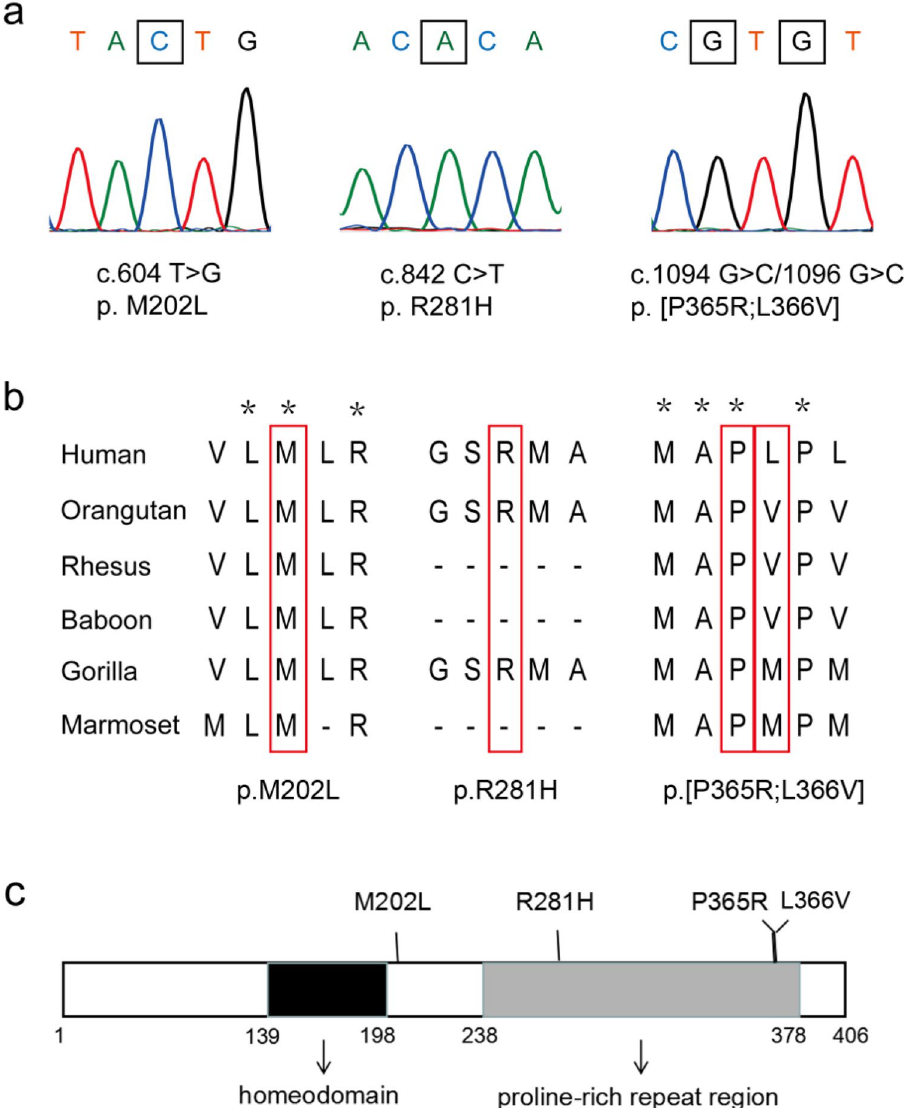
Figure 1. Missense mutations of ESX1 identified in patients with NOA. ( a ) Four missense mutations were validated by PCR-Sanger sequencing. Mutation sites are marked with a black box. ( b ) The evolutionary conservation of each amino acid altered by these mutations was analyzed via multiple protein sequence alignments. ( c ) Schematic representation of ESX1 protein and its missense